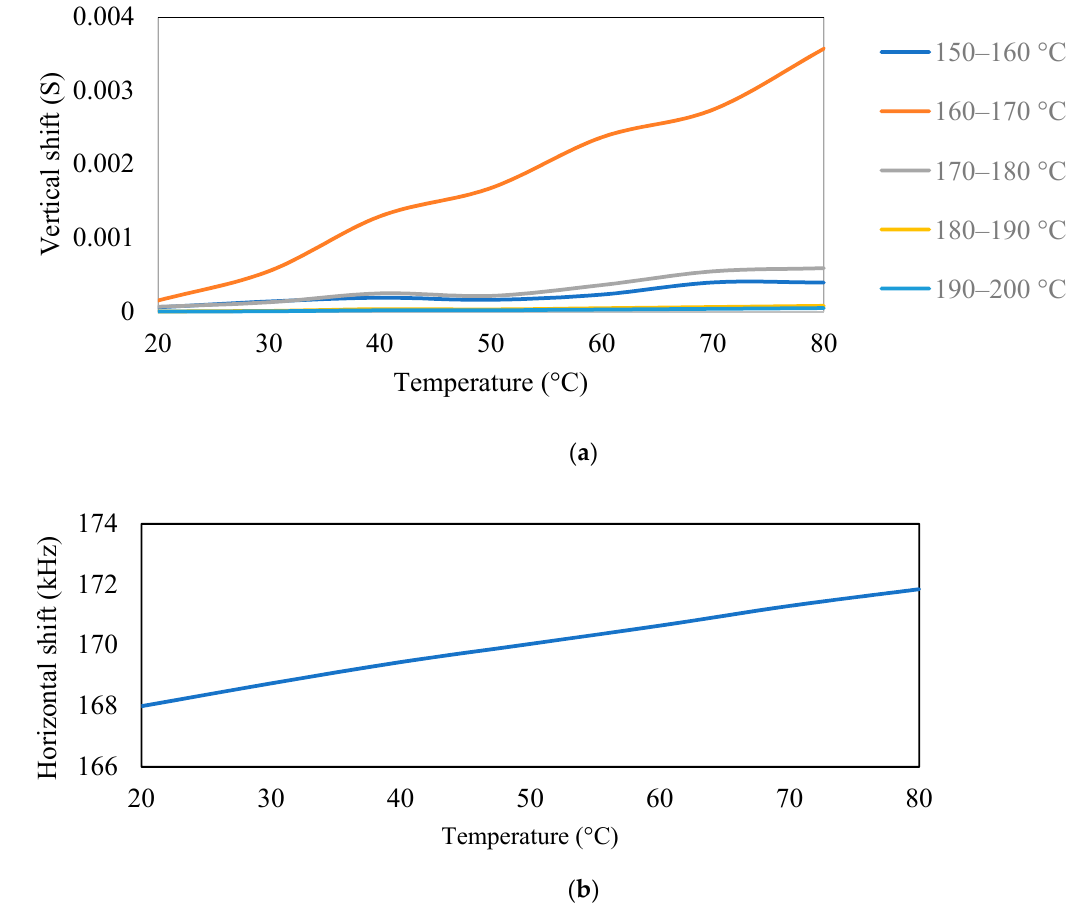
Figure 8. ( a ) Vertical shift; ( b ) horizontal shift as a function of temperature.